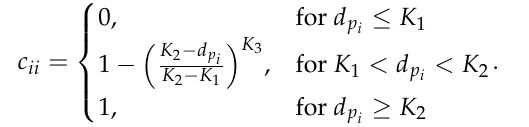
Figure 3. Schematic representation of the classification